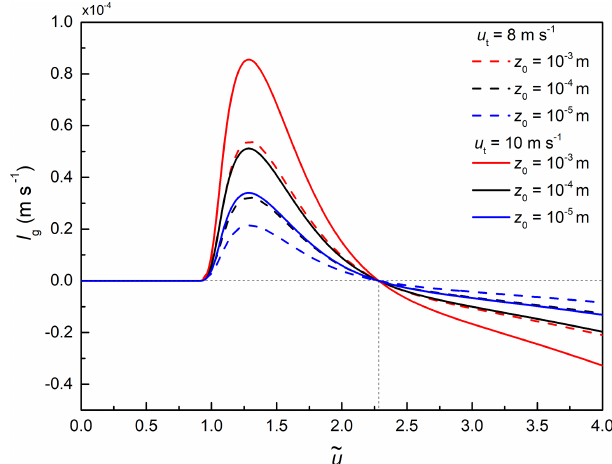
Figure 9. Estimations of cornice length growth rates in the